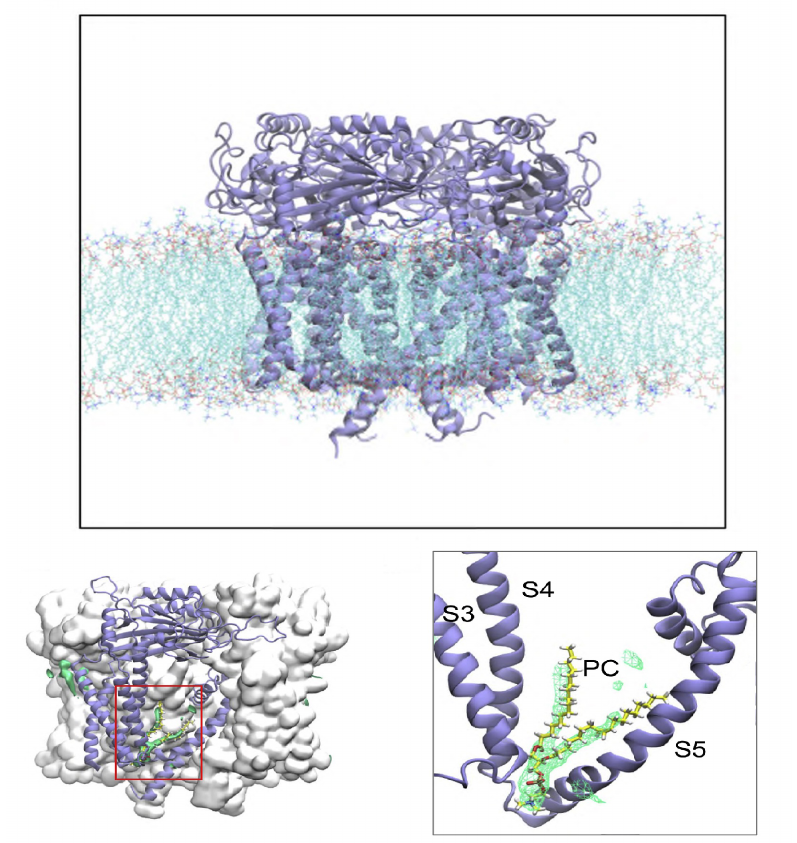
Figure 5. Identification of lipid-binding sites via molecular dynamics simulation. PC2 is an example of the identification and analysis of the role of lipids acting as a direct regulator of protein structural changes. The upper panel shows a snapshot from an molecular dynamics (MD) simulation of the PC2 channel (PDB: 5K47) embedded in the lipid bilayer. In the two bottom panels, enlargements of the protein (gray surface, with one subunit in purple) are shown, highlighting the binding pocket and the position of the lipid molecule. Adapted from [194] under the CC BY